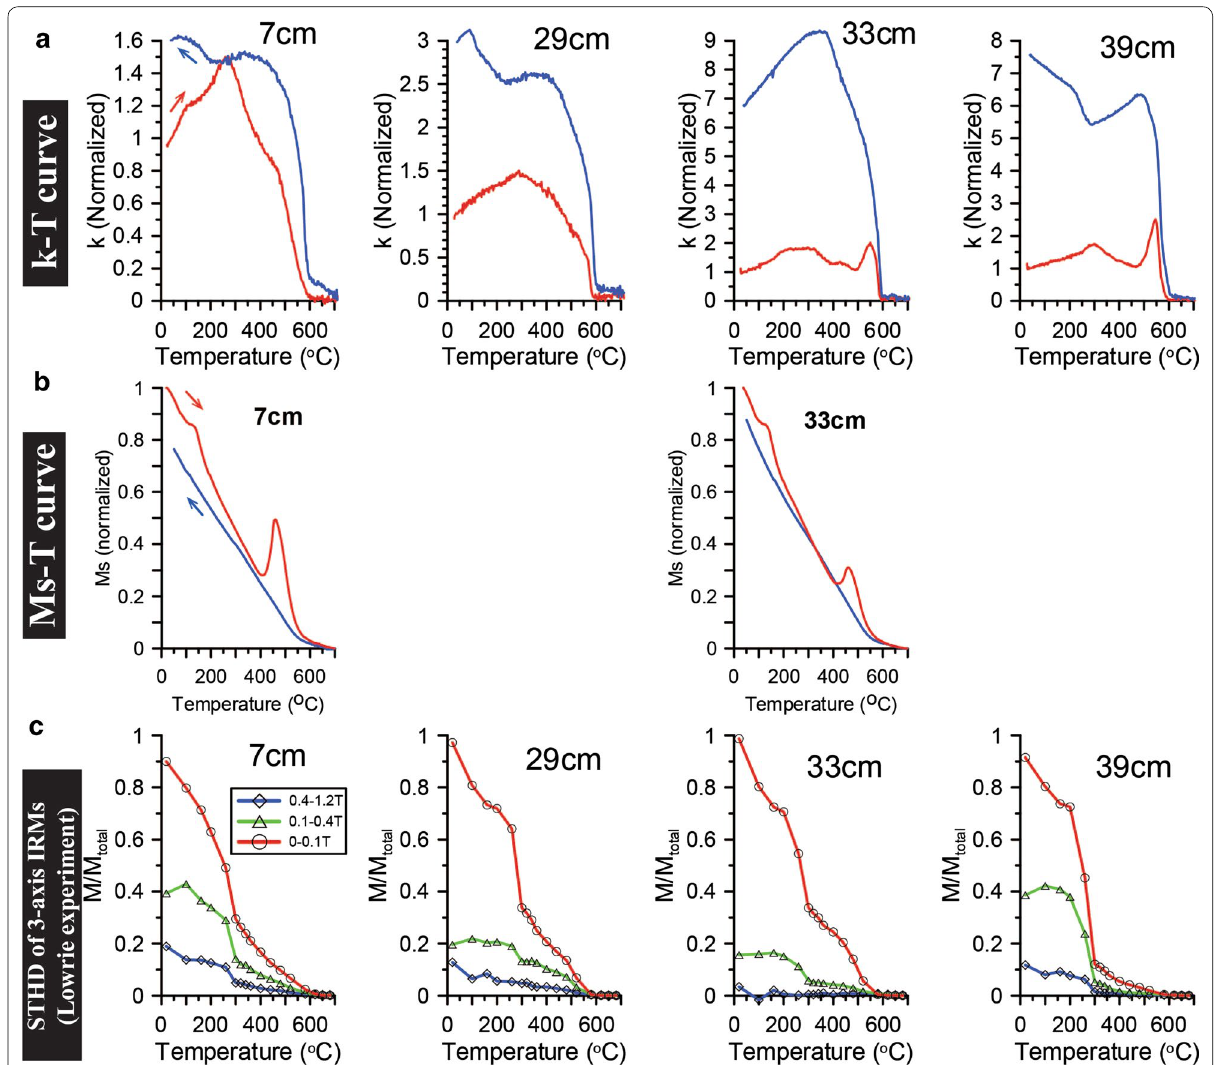
Fig. 7 Results of a high‑temperature weak‑field thermomagnetic ( k – T ) curve, b high‑temperature strong‑field thermomagnetic (Ms– T ) curve, and c STHD of 3‑axis IRMs with different coercivities (Lowrie 1990), from selected horizons (7, 29, 33 and 39 cm depth of the GSDS1